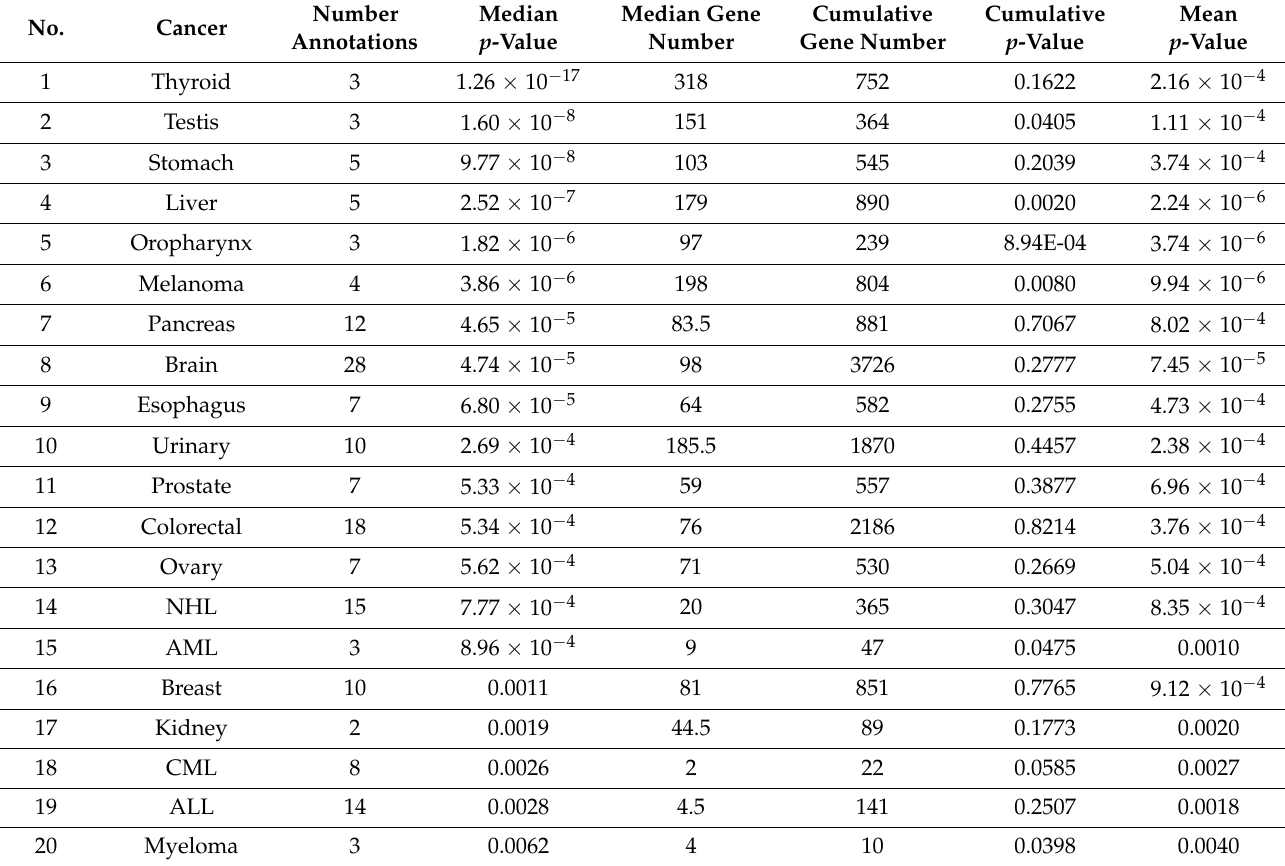
Table key: The experimental condition considered in this Table is the overall results (cannabis dependence and withdrawal combined). Cancers were grouped by cancer type. The table lists the various classes of gene numbers and p -values as described in the column headings. All data is taken from results reported from the epigenomic data appendix in the study of Schrott and colleagues as referenced